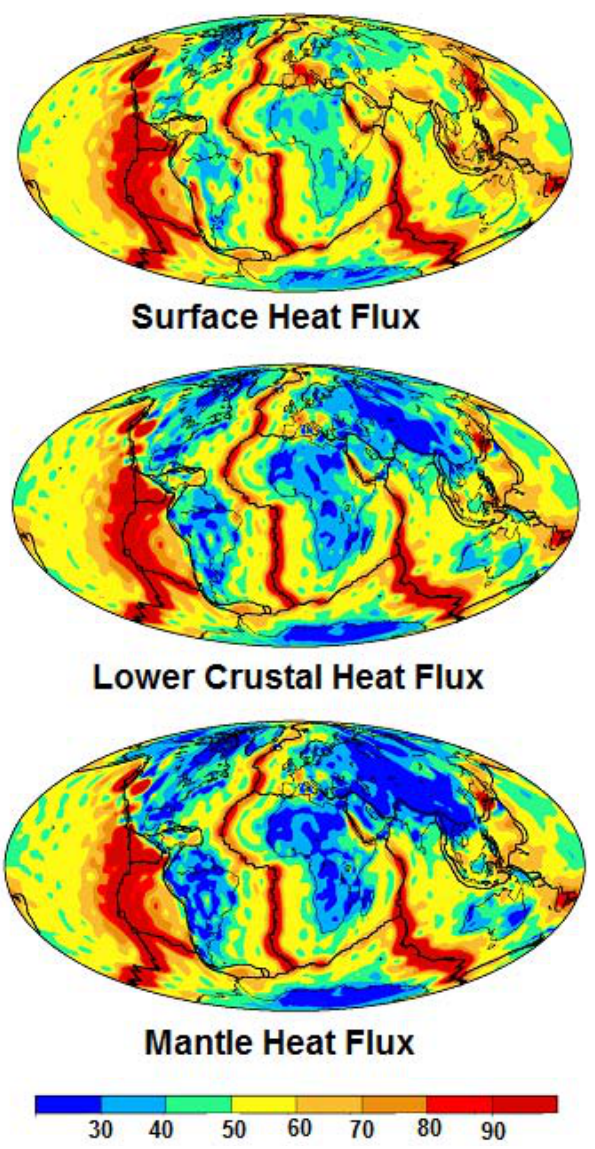
Fig. 7. Heat flow corrected for contributions of radiogenic heat at the base of sedimentary layers (upper panel), base of upper crust (middle panel) and base of lower crust (lower panel). Note that near surface heat flow (upper panel) provides very few clues as to the contrasts in the deep thermal structures of continental and oceanic regions. As the contributions of radiogenic heat of upper and lower crustal layers progressively remove the differences in deep heat flux between these regions becomes evident (middle and lower panels).